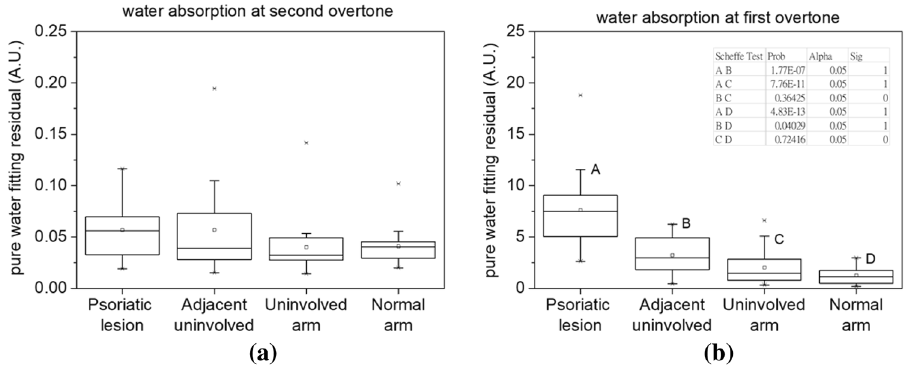
Figure 4. Statistics summary of pure water fitting residuals of the four measurement sites at the second and first overtone bands of water absorption. ( a ) Box-and-whisker plots shows that the means of pure water fitting residuals near 970 nm of the four sites are comparable. The P -value of one-way ANOVA was 0.21, indicating that the population means were not significantly different. ( b ) Box-and-whisker plots shows that the means of pure water fitting residuals near 1300 nm of the four sites. The P -value of one-way ANOVA was 9.65E−15, indicating that the population means were significantly different. Inset table shows Scheff ѐ test P -values between any two groups, and Sig equals to 1 indicates that the difference of the means is significant at the 0.05